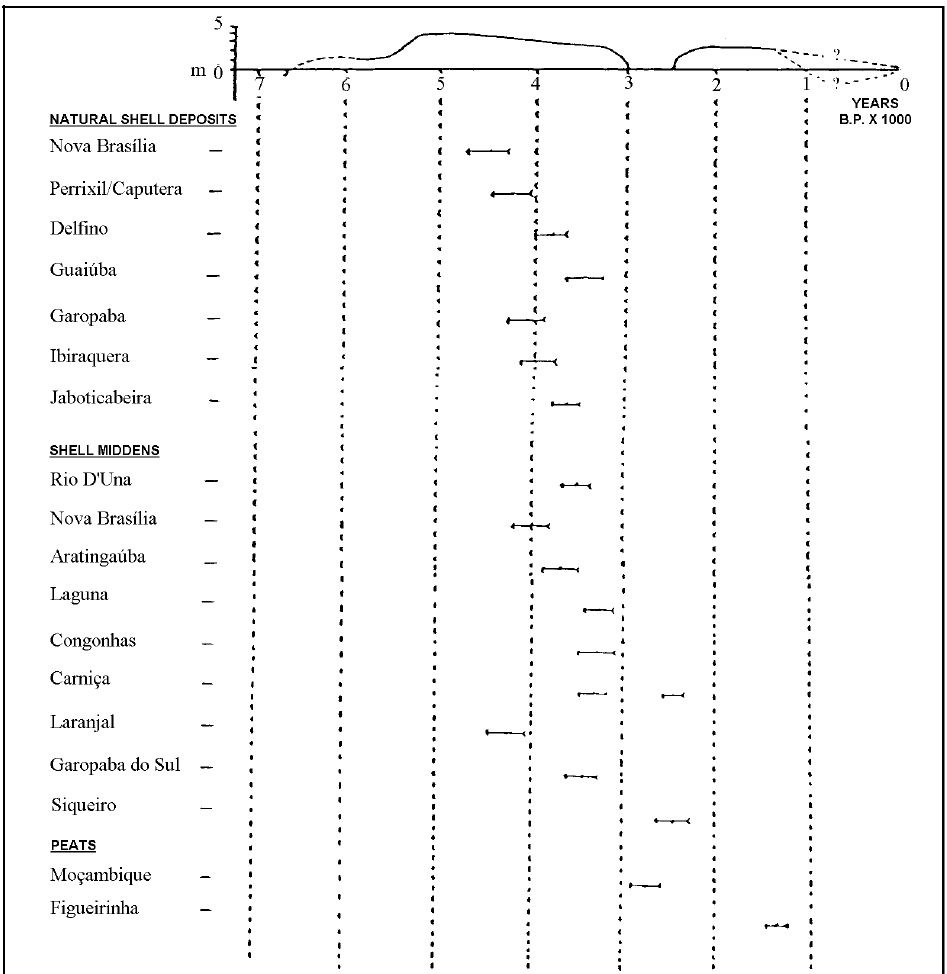
Fig. 7 – Relationship between radiocarbon ages of natural shell beds, shell-middens and peats with the sea-level curve outlined by Suguio et al. (1985), Martin et al. (1988) and Caruso Jr. (1989,